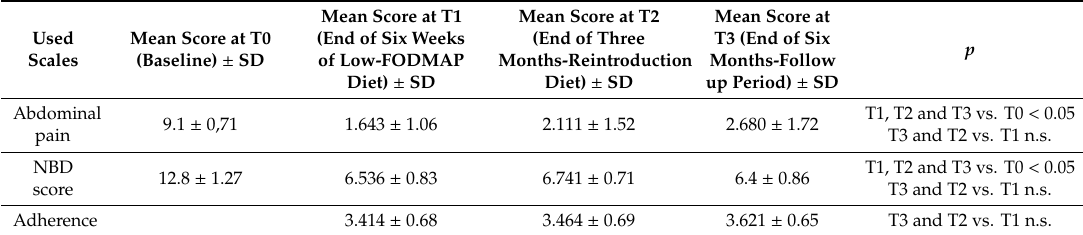
Table 3. Description of abdominal pain, neurological bowel dysfunction (NBD) score, and adherence at T0, T1, T2, and